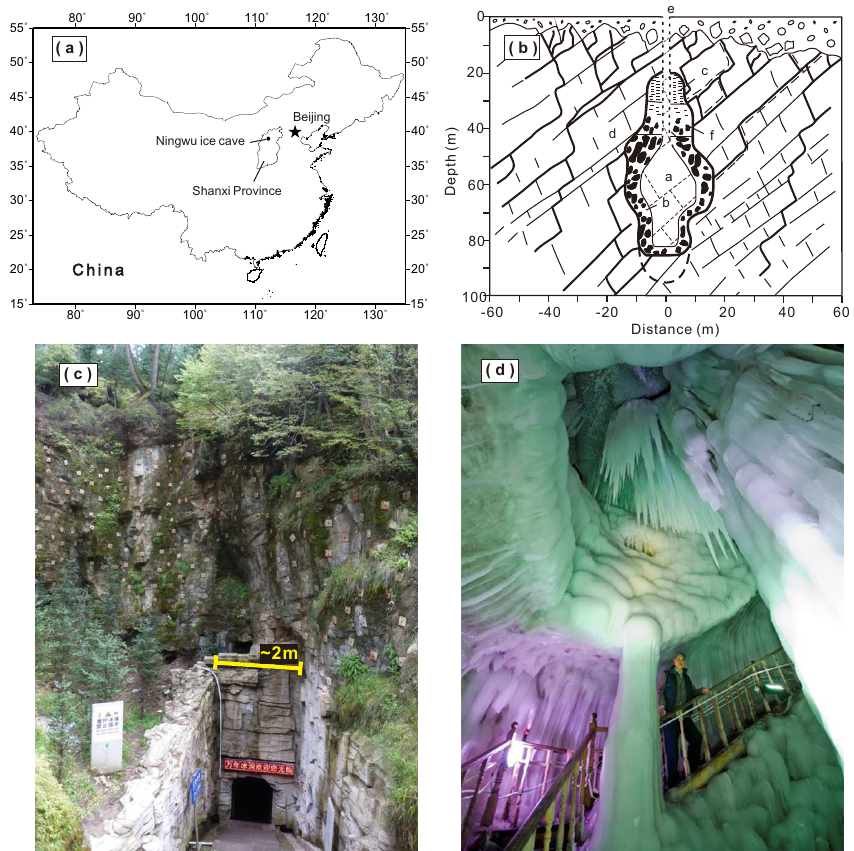
Figure 1. Location (a) , cross section (b) , entrance (c) and inside (d) of Ningwu ice cave. In (b) : (a) the main cavern, (b) block ice, (c) layered ice, (d) limestone, (e) the entrance, and (f) a